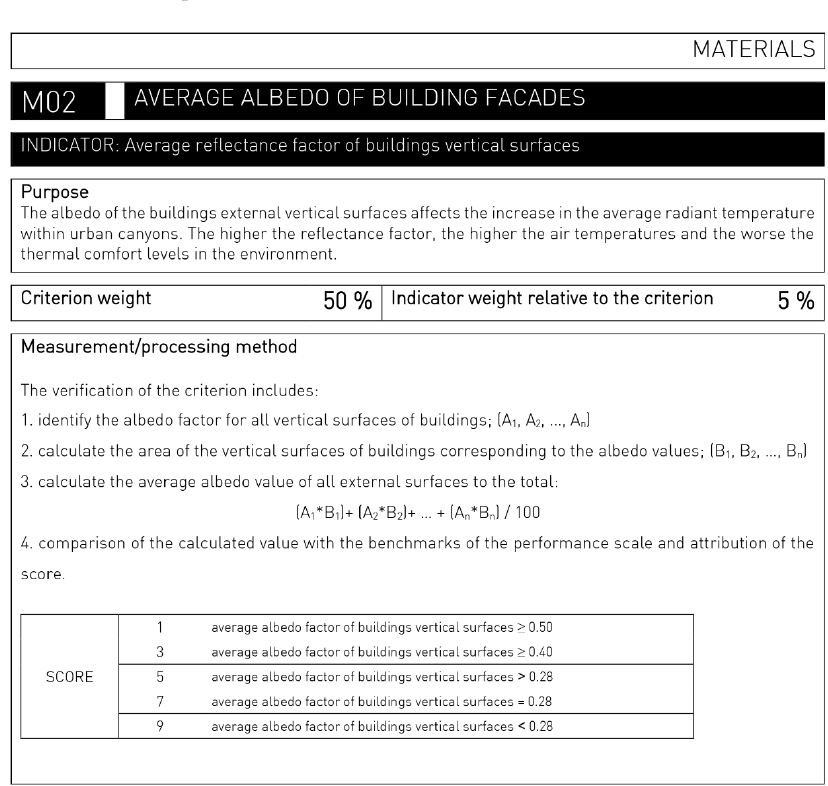
Energies 2021 , 14 , x FOR PEER REVIEW Figure A9. Descriptive sheet of the indicator of “Permeable surfaces”. Figure A9. Descriptive sheet of the indicator of “Permeable surfaces”.